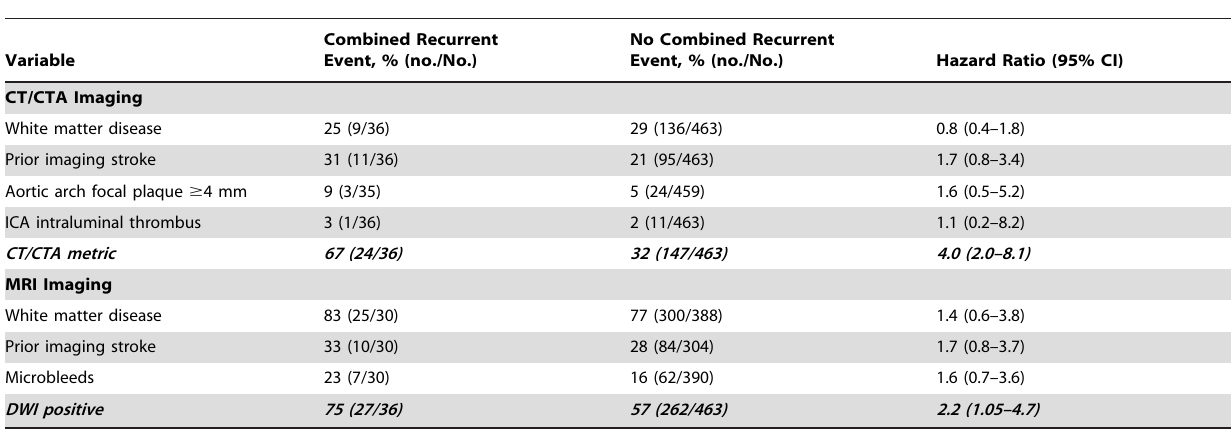
Table 2. Effect of new imaging parameters on combined recurrent events (including symptom progression and a distinct recurrent